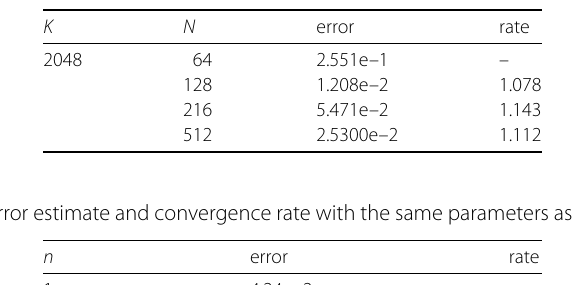
Table 2 Error estimate and convergence rate for the time direction with the same parameters as used in Fig. 1(c)